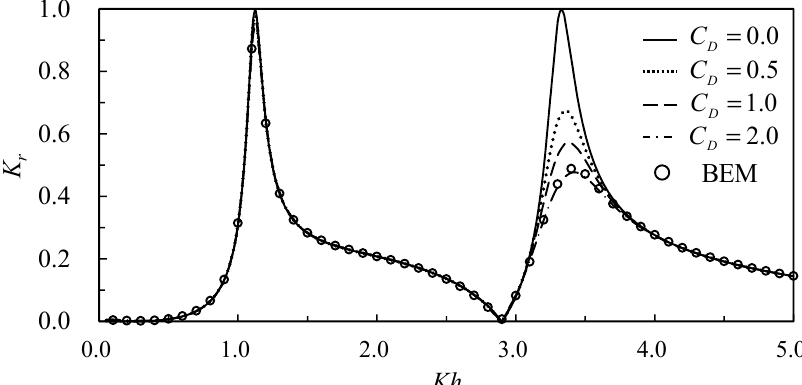
Figure 7. Reflection coefficient versus relative water depth for various drag coefficients ( d 1 / h = 0.25, (cid:96) / h = 0.2, a / h = 0.3, and C = 2.0).